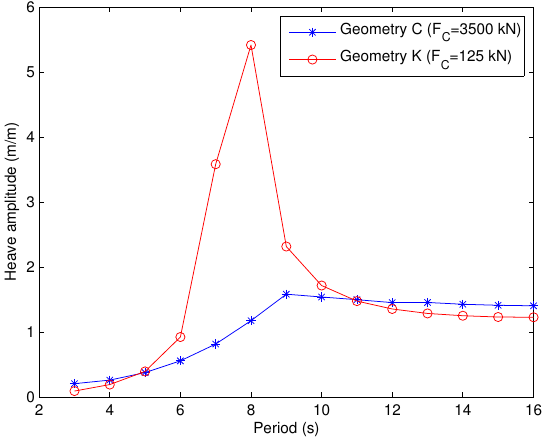
Figure 9. Response amplitude operator (RAO) for optimal geometries with constrained PSOC. PTO constraints: k C = 0.75, and the force constraints are F C = 3500kN (for geometry C) and F C = 125kN (for geometry K).